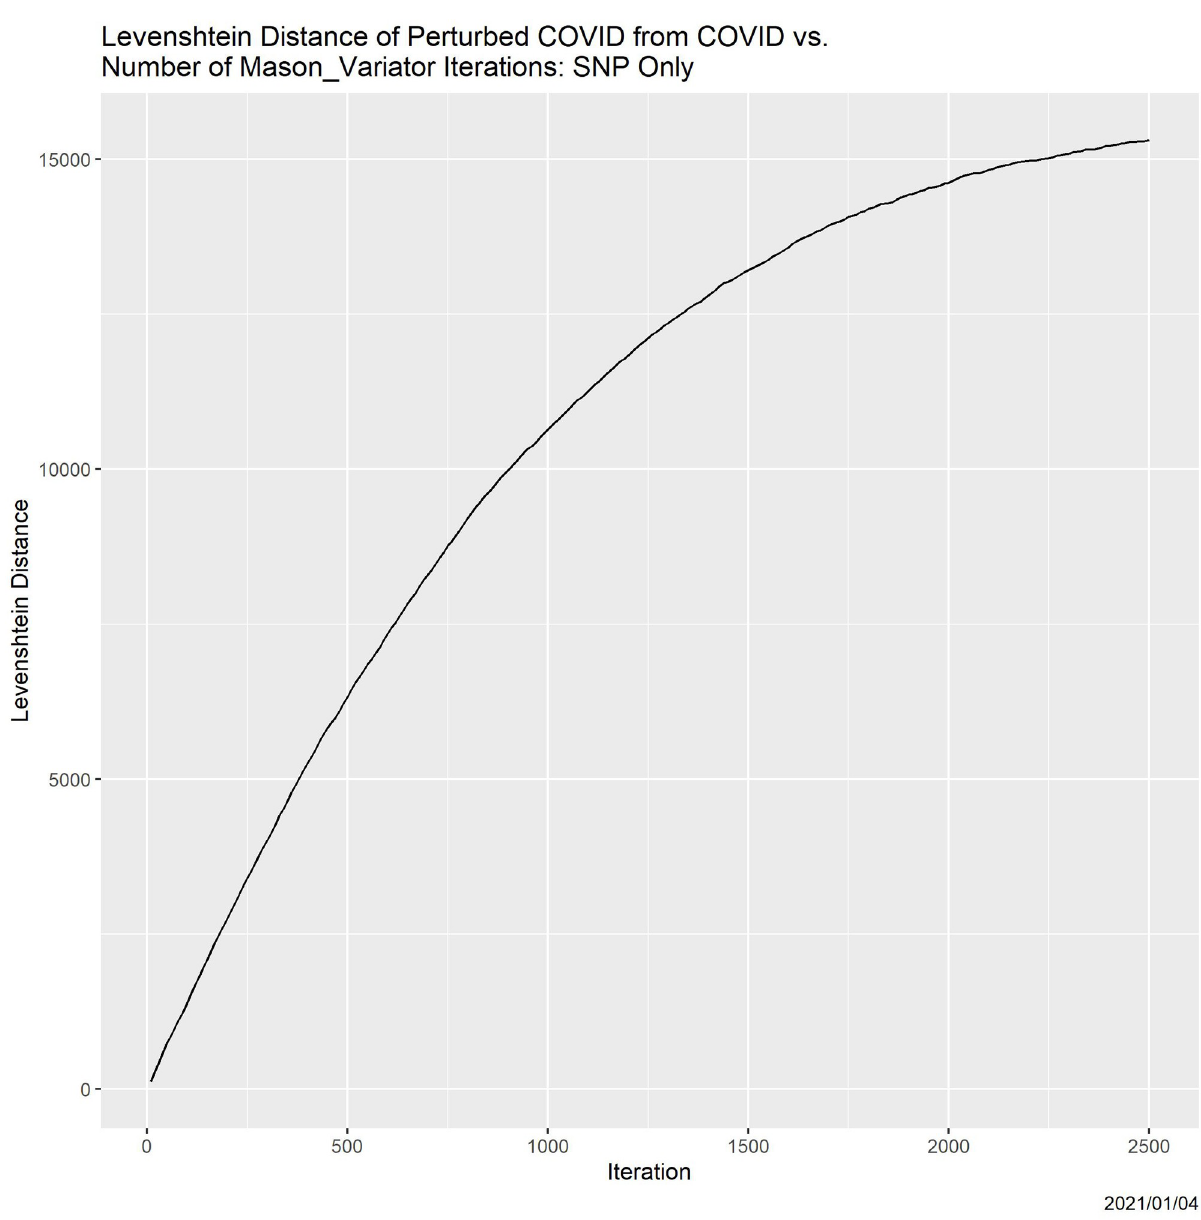
Fig 1. Examplar of degradation. Levenshtein distance from a (randomly selected) coronavirus genome as a function of the number of Mason_variator iterations.